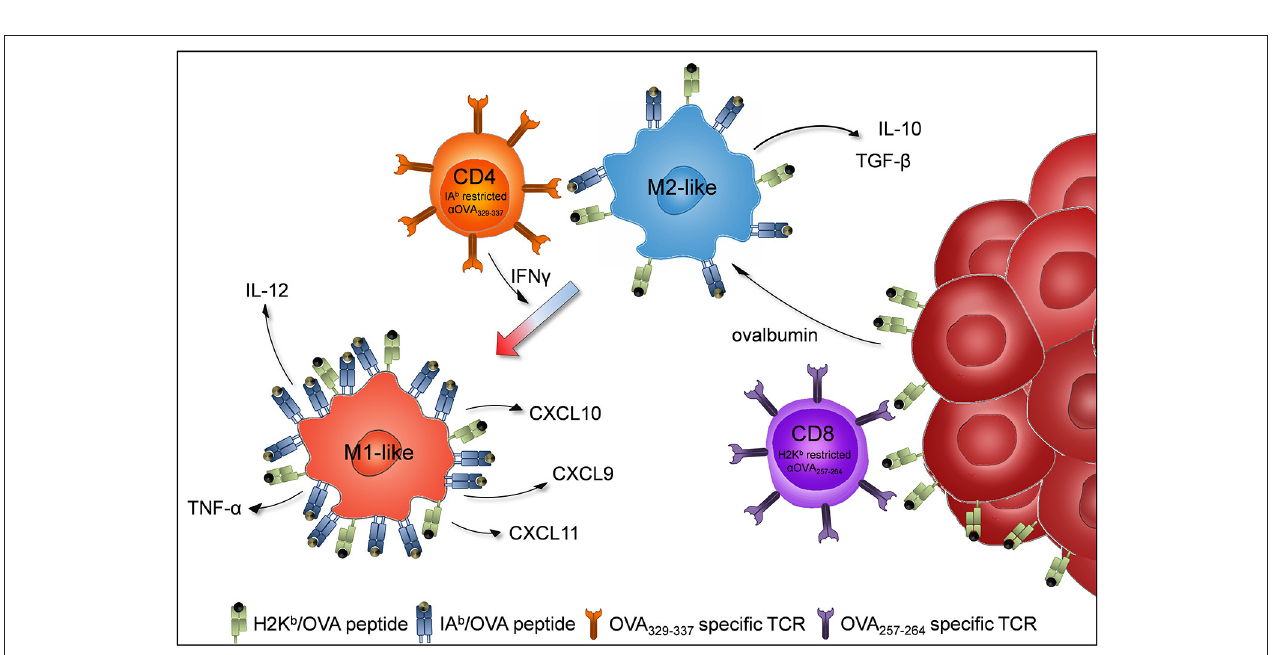
FIGURE 7 | Proposed model of TAM repolarization upon adoptive transfer of tumor antigen-specific CD4 + Th1 cells. B16F10 cells (dark red) are injected subcutaneously into C57BL/6J mice to induce tumor growth. Tumor infiltrating M2-like macrophages (blue) engulf ovalbumin released by tumor cells and present MHC class II (IA b ) restricted OVA epitopes to adoptively transferred OVA specific CD4 + Th1 cells (orange). The activated CD4 + Th1 cells secrete IFN γ which induces macrophages to polarize to proinflammatory M1-like macrophages (light